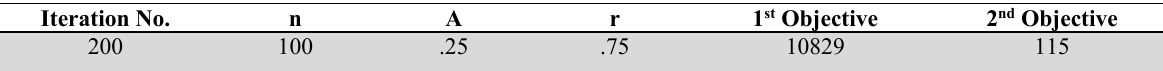
Parameter values of MOBA Pareto front Iteration